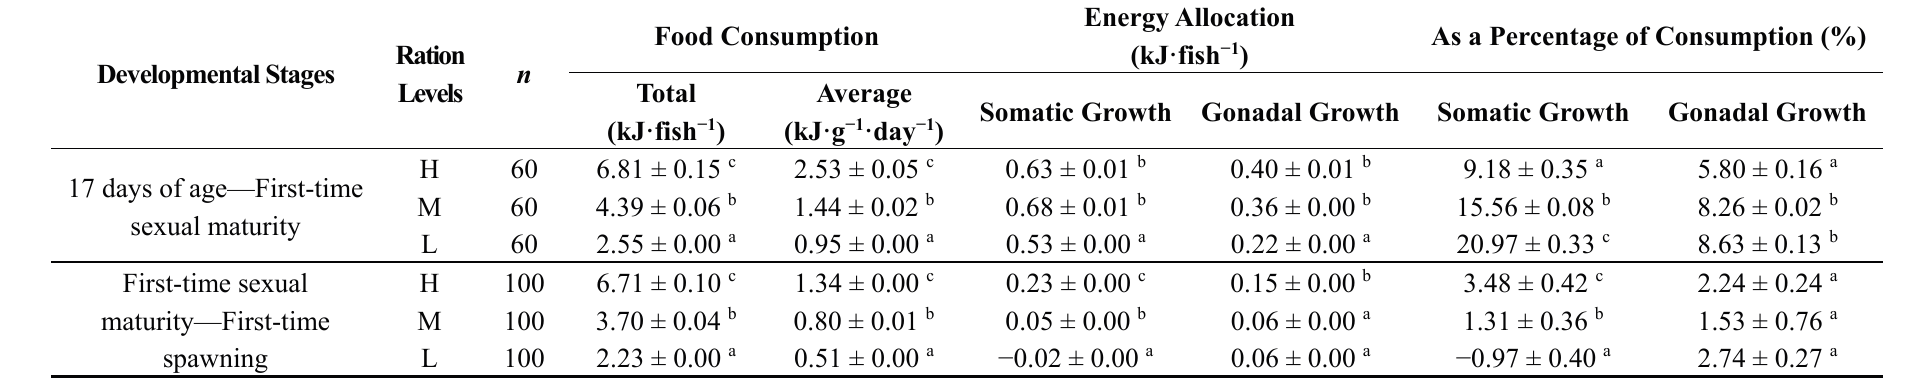
Table 2. Energy allocation of female G. affinis at three ration levels in different developmental stages